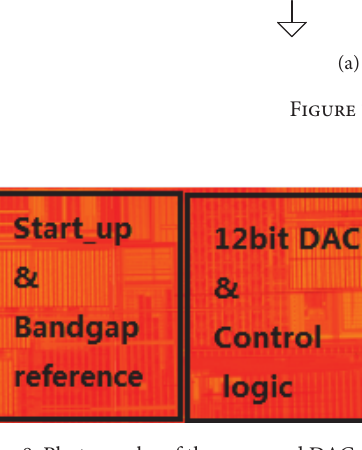
Figure 8: Photography of the proposed DAC chip.